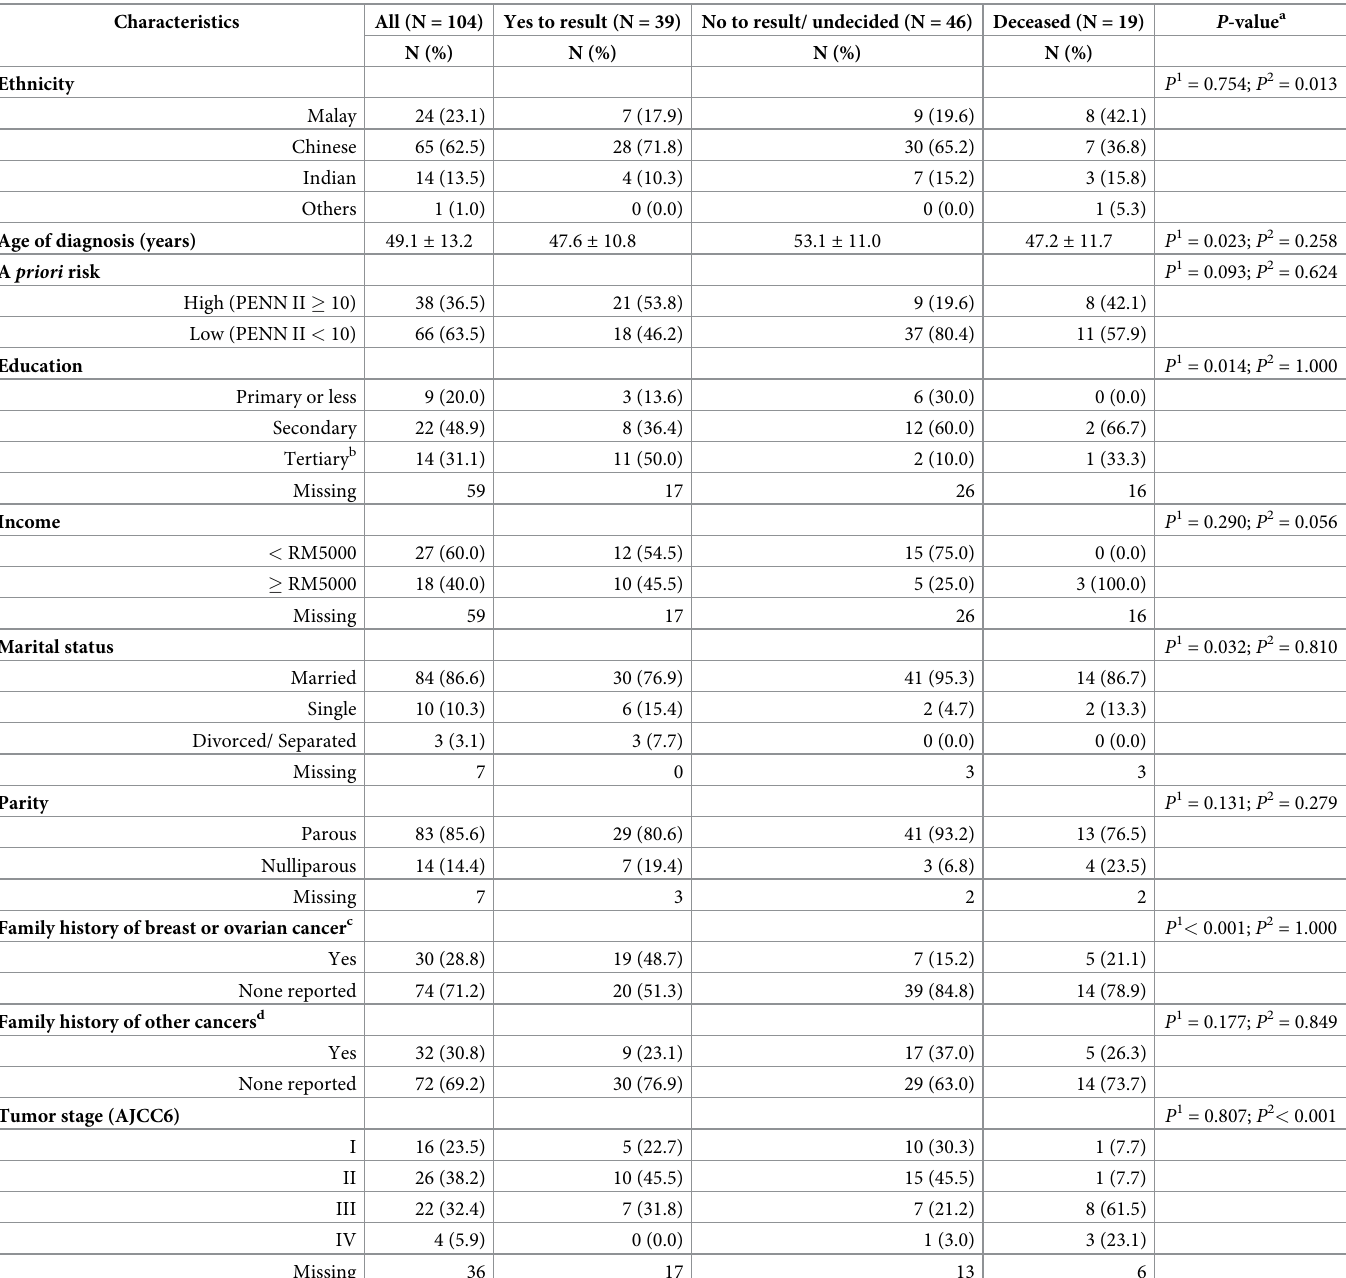
Table 1. Demographic characteristics of carriers.